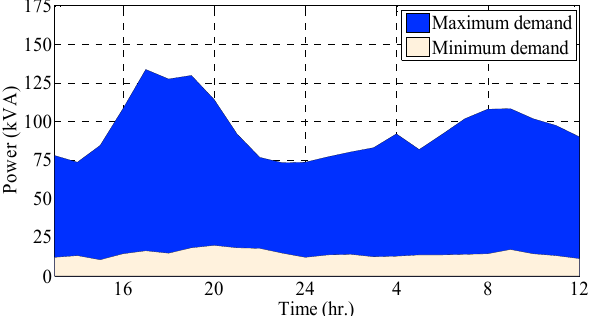
Figure 9. Minimum and maximum load profile at the substation of test network.